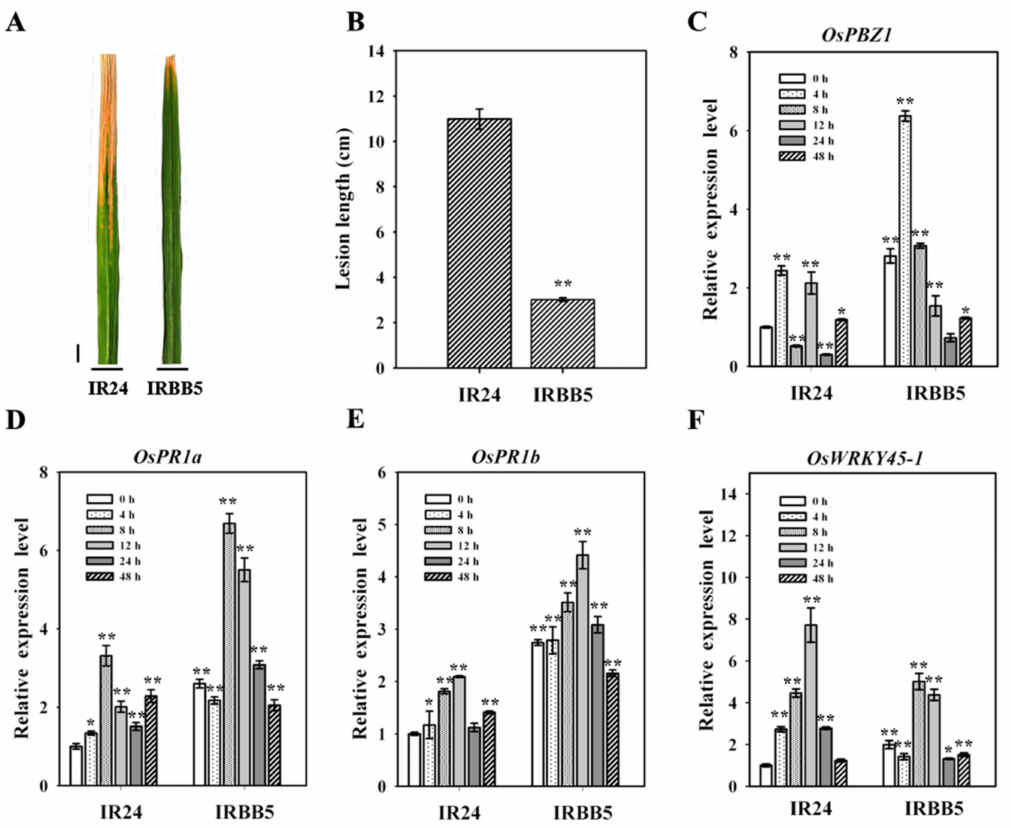
Figure 1. Comparison of bacterial blight responses of IRBB5 and IR24. ( A ) Disease symptom during Xoo inoculation of the IRBB5 and IR24. The indicated rice genotypes were inoculated with Xoo strain PXO86 at tillering stage in the planting field. ( B ) Lesion lengths in IRBB5 and IR24 at 14 days post inoculation with Xoo strain PXO86. ( C – F ) Expression pattern of four published defense-responsive genes in IRBB5 and IR24 under Xoo strain PXO86 treatment. RNA was extracted at the indicated time points for qRT-PCR experiments, and the relative expression values of all samples were normalized by quantifying the miRNAs transcription of IR24 0 h samples. Scale bar, 1 cm. Bars represent mean ± standard deviation ( n = 3 independent biological replicates). Asterisks indicate a statistically significant di ff erence (** p < 0.01, * p <